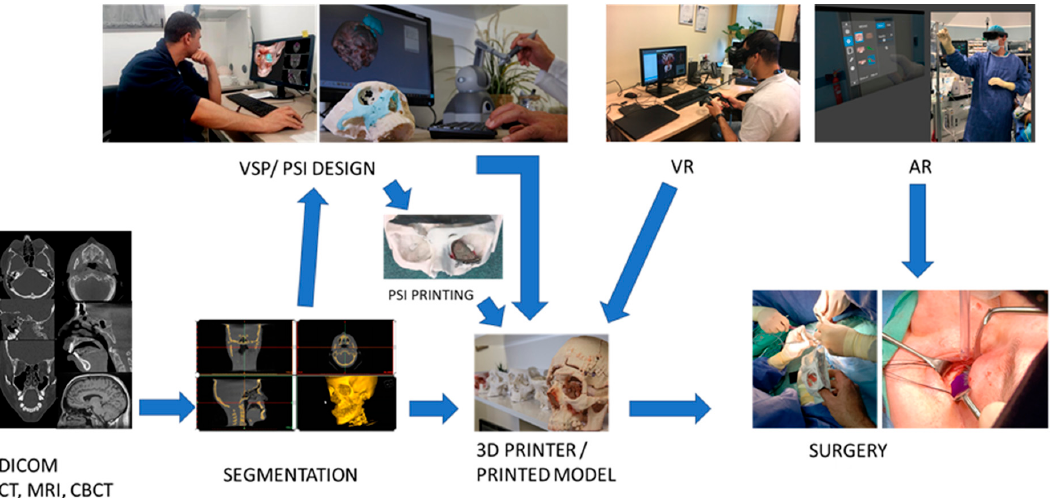
Figure 2. Workflow at the 3DP PoC facility. Patients’ volumetric data obtained after medical imaging is translated to digital imaging and communication in medicine (DICOM) format, followed by segmentation and 3D rendering for virtual surgical planning (VSP) and patient specific implant (PSI) design. Both models and implants are 3D printed, sterilized and subsequently used for surgery. Virtual reality (VR) is used for further evaluation and simulation before surgery. Augmented reality (AR) may assist the surgical team during surgery.